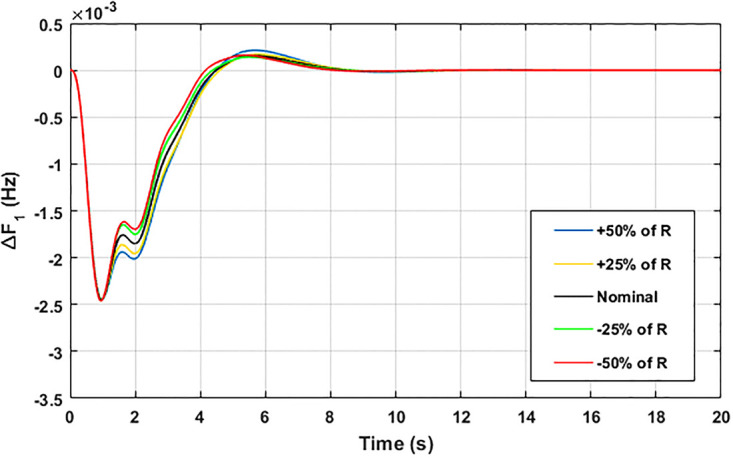
Results for variation in R with ΔF1.